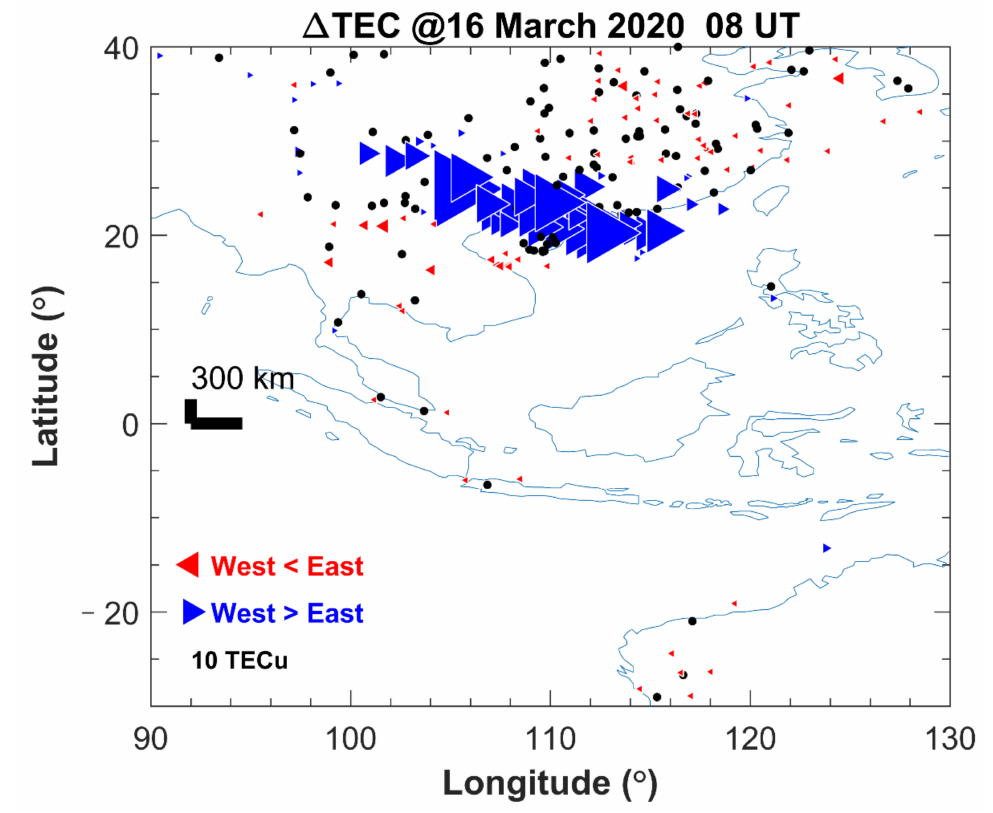
Figure 6. Similar to Figure 2, but for the case at 08 UT on 16 March (DOY 076)